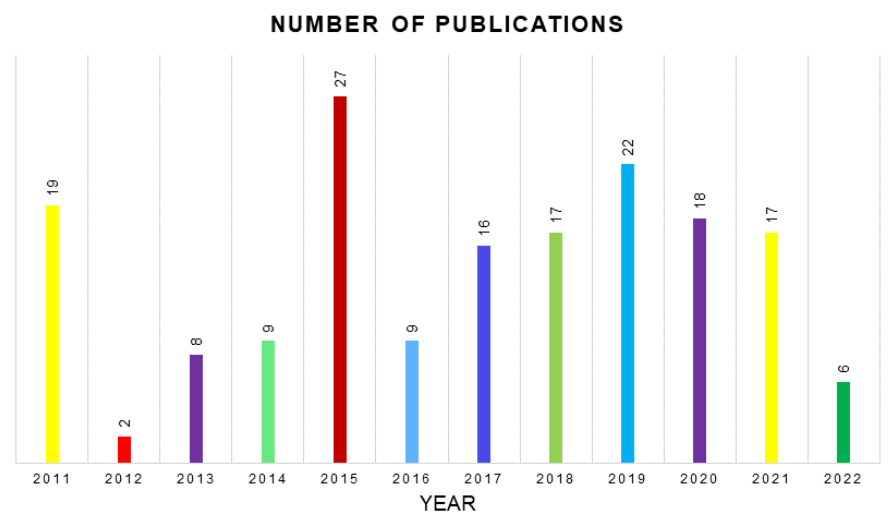
Figure 4. Number of publications related to “Virtual Rehabilitation and Assistive devices” by year [8].